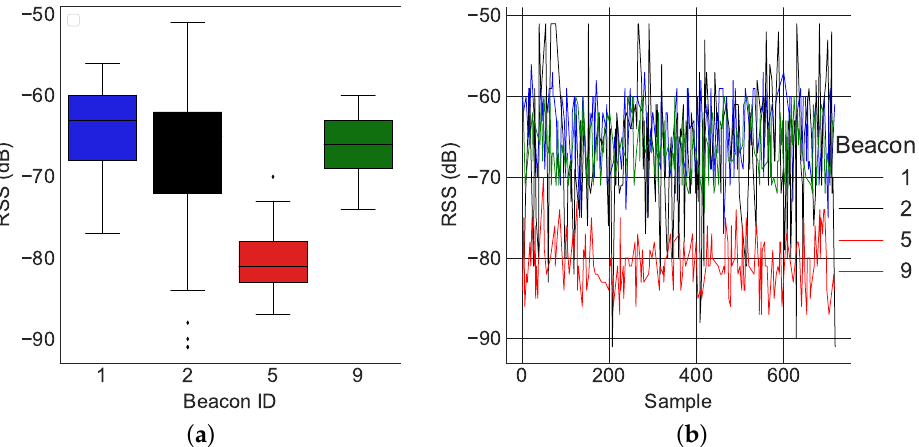
Figure 14. RSS at Reference point 11. ( a ) Distributions of RSS for different beacons; ( b ) RSS versus sample number (samples are taken at 4